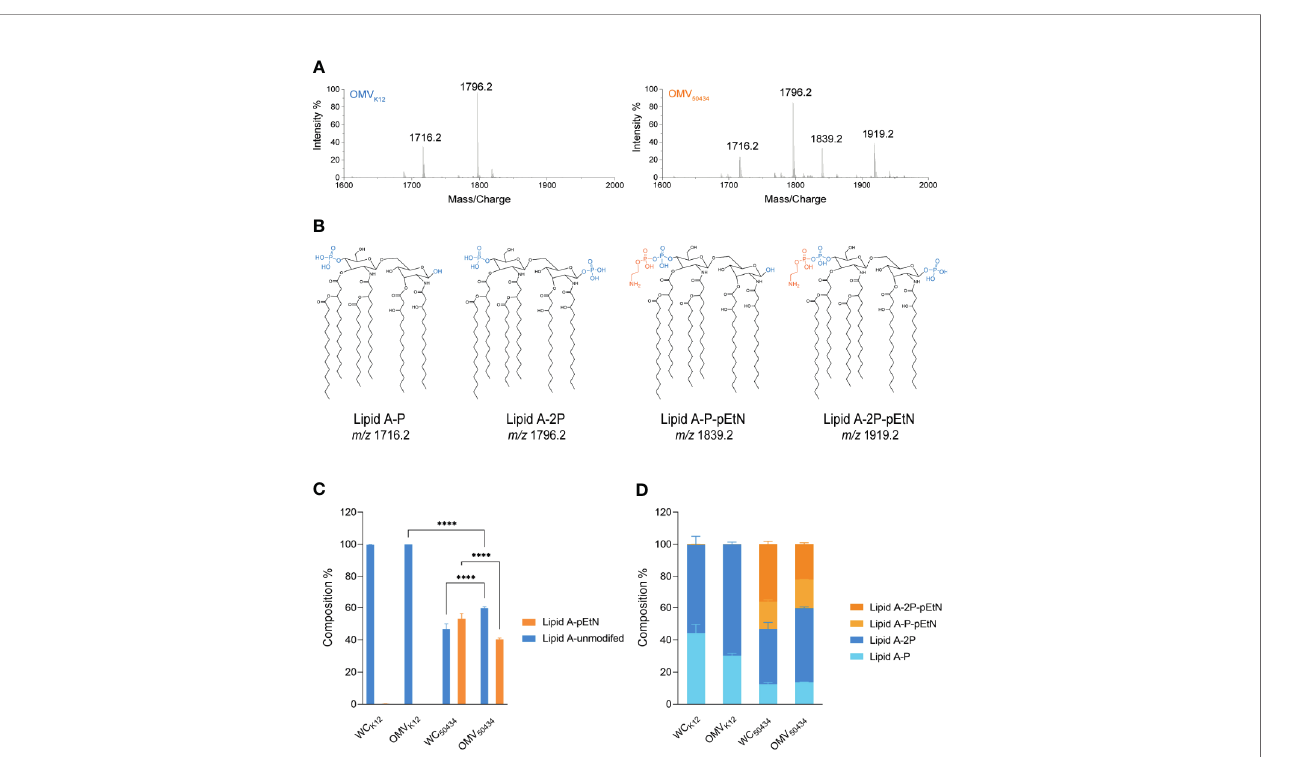
FIGURE 4 | Characterization and relative quantitation of lipid A in OMVs and the producer whole cells (WCs) by LC-MS. (A) Representative mass spectra of lipid A from E. coli K12 OMVs (left) and E. coli 50434 OMVs (right). (B) Structures of lipid A species identi fi ed by mass spectrometry. Phosphate group, blue; pEtN, orange. (C, D) The composition of lipid A species was relatively quantitated of peak area with MultiQuant 3.0. Asterisks (*) denote statistical signi fi cance as determined by two-way ANOVA followed by Turkey ’ s multiple-comparison test (**** P < 0.0001, n =